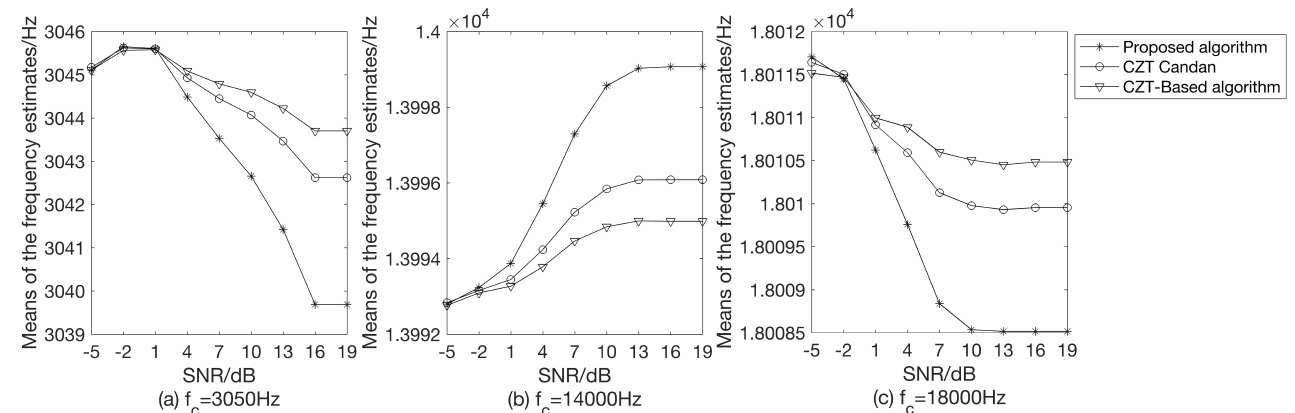
Figure 4. Means of the frequency estimates for the multiple-tone signal versus the SNR.